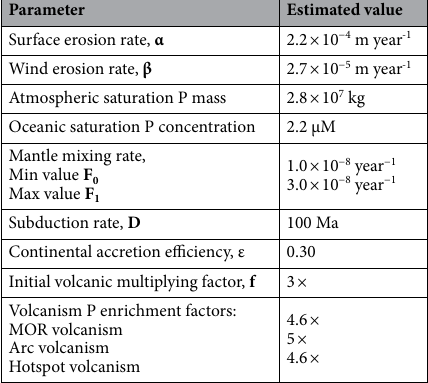
Parameter Estimated value Surface erosion rate,